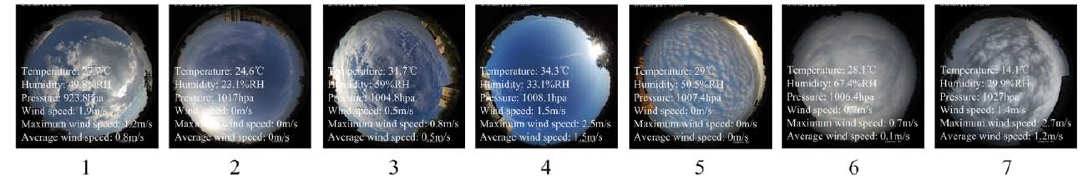
Figure 3. The cloud samples on the MGC dataset. The Arabic numeral below each sample denotes the corresponding class